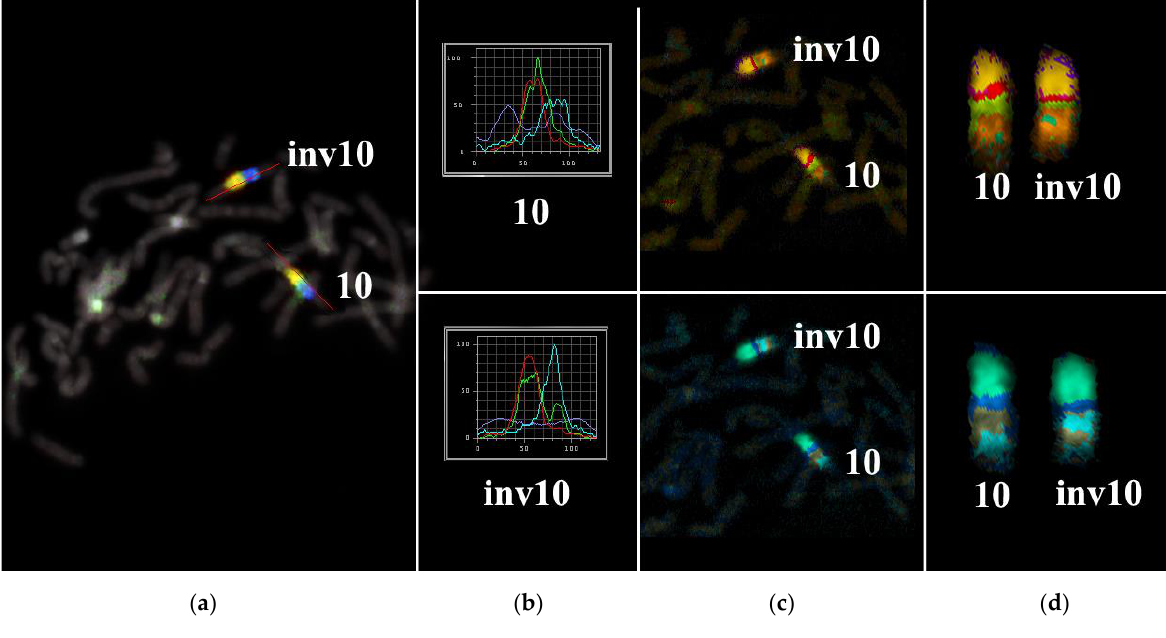
Figure 3. Multicolor FISH analysis of the long arm of chromosome 10 from the patient. ( a ) Three- color FISH of microdissected DNA probes [a combination of 10A (red), 10B (green), and 10C (blue)] labeled with different fluorochromes on metaphase chromosomes of the patient. The red line along chromosome 10 is the line along which the intensity profiles of hybridization signals were determined. ( b ) Profiles of signal intensities for abnormal [inv(10)] and normal chromosomes 10. ( c , d ) Different types of MCB pseudo-color classifiers are presented. inv10: chromosome 10 with the paracentric inversion in the q arm; 10: normal chromosome